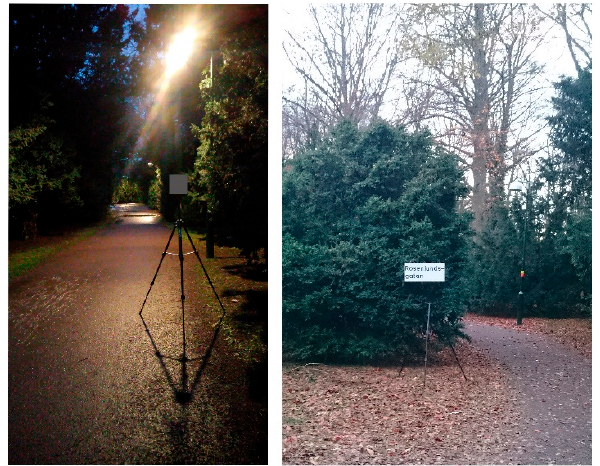
Figure 4. The setup of the facial expression recognition and sign reading tasks. The photograph used for the facial expression recognition task is excluded due to copyright.